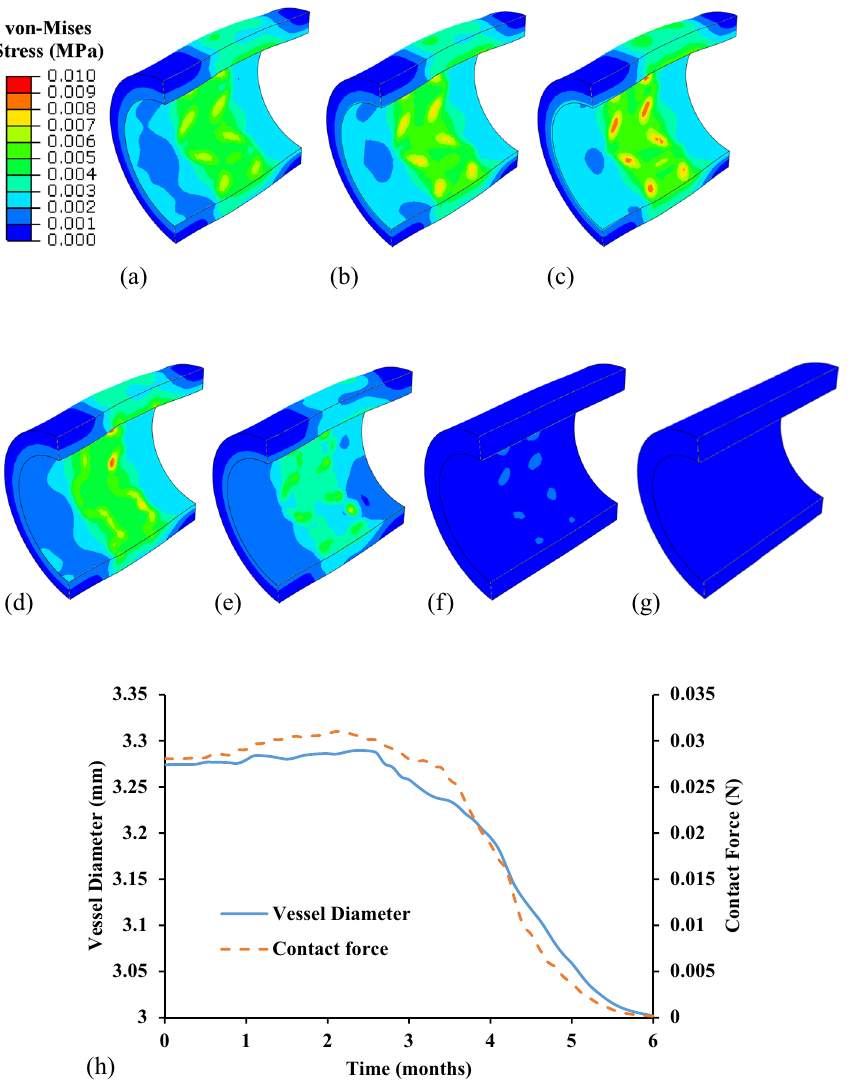
Figure 6: Dynamic stent – artery interaction during degradation. ( a – g ) Contour of von - Mises stress of artery at ( a ) 0 month, ( b ) fi rst month, ( c ) second month, ( d ) third month, ( e ) fourth month, ( f ) fi fth month, and ( g ) sixth month. ( h ) Change in vessel diameter and contact